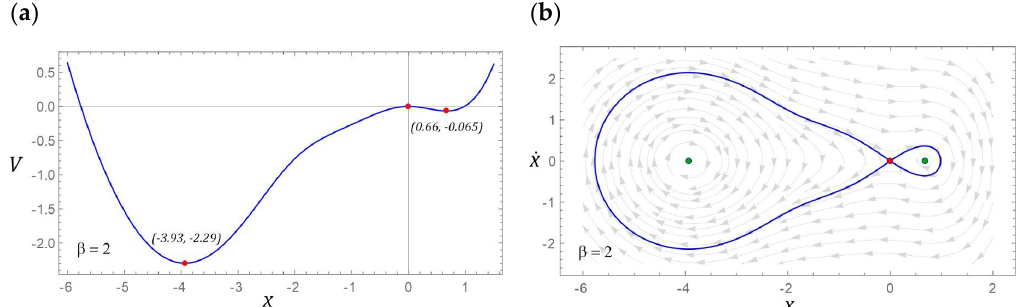
Figure 8. The location of fixed points is shown as ( a ) potential characteristics, ( b ) phase plane with the corresponding homoclinic orbits and vector fields.